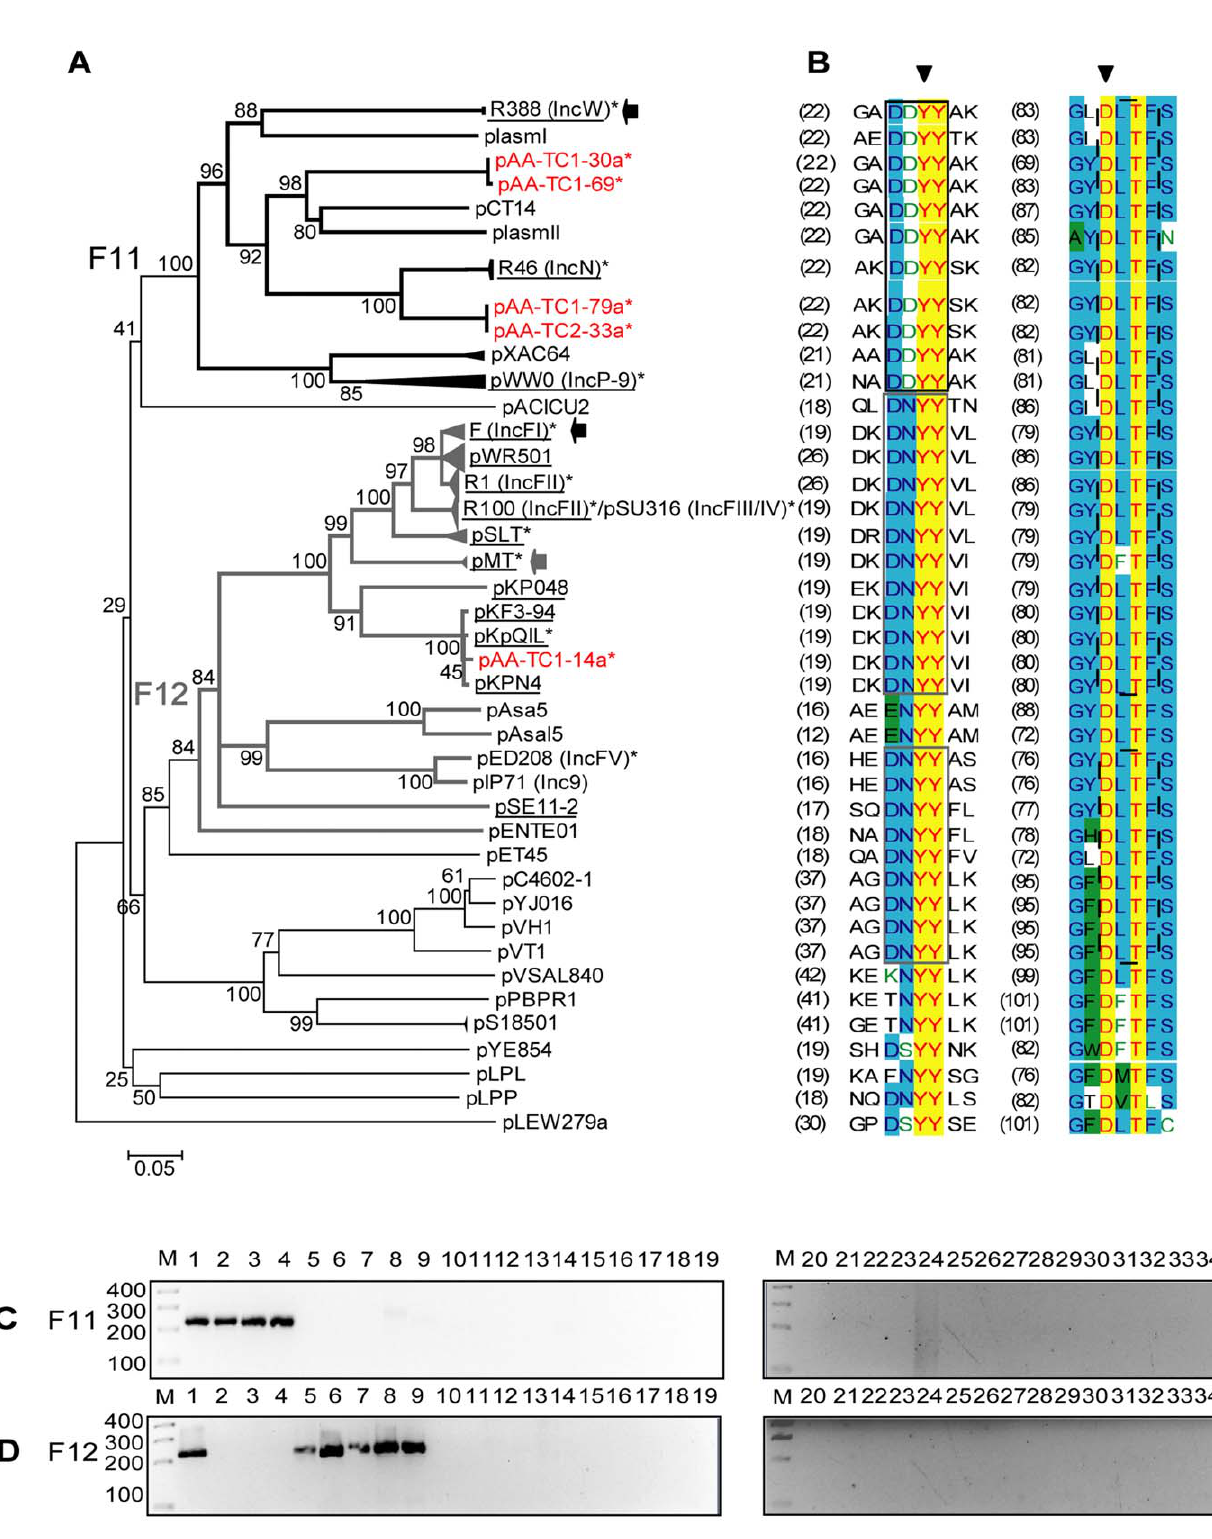
PLoS ONE | www.plosone.org